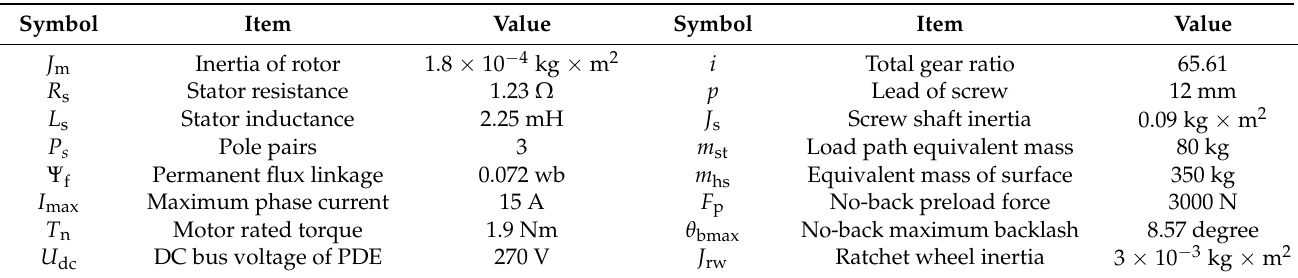
Table 3. Parameters for model implementation.